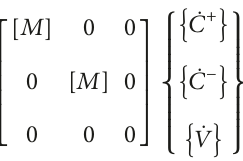
with a low value of 𝛼